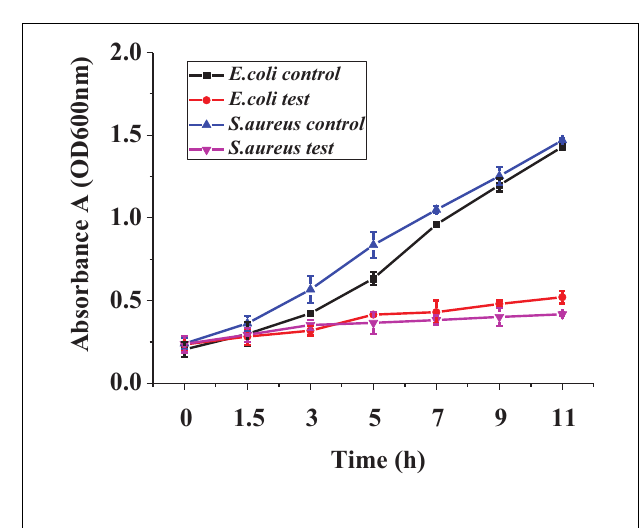
prolonged. However, the phosphorus contents in the inoculum of the two treated bacteria were both higher than those of the two controls throughout the processing, which